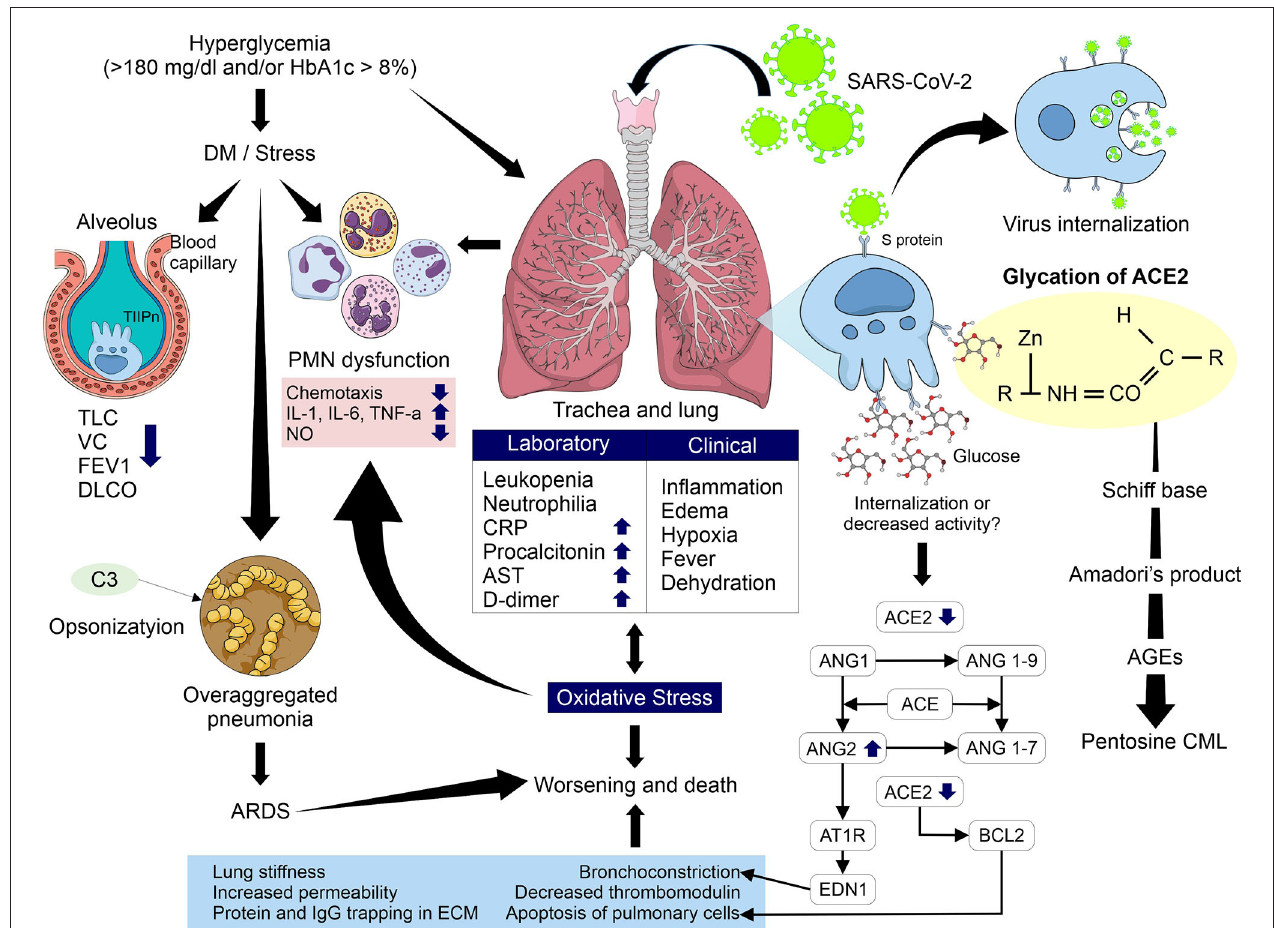
FIGURE 4 | Pathophysiological mechanism involved in glycation of ACE2 in uncontrolled hyperglycemic patients with and without DM and its relationship with complications and mortality due to COVID-19. Glycation may modify the activity of ACE2 causing a several reactions such as increased levels of Ang II, greater interaction with its receptor AT1R, increasing levels of endothelin-1, decreased activity of Bcl-2, and greater interaction of glycation products with type II pneumocytes. These processes increase bronchoconstriction, apoptosis of pulmonary cells, lung stiffness, permeability, and protein and IgG trapping in ECM and decreased thrombomodulin. In addition, an increase in OS, PMN dysfunction and the alterations induced by hyperglycemia and the higher risk of over-aggregated pneumonia in COVID-19 patients could increase the risk of ARDS and therefore of worsening evolution and death. TLC, total lung capacity; VC, vital capacity; FEV1, forced expired volume in 1 second; DLCO, Pulmonary diffusion capacity; PMN, polymorphonuclear; IL, interleukin; TNF- α , tumor necrosis factor alpha; NO, nitric oxide; CRP, C-reactive protein; AST, aspartate aminotransferase; T2Pn, type 2 pneumocytes; ACE, angiotensin converting enzyme; ACE2, angiotensin converting enzyme 2; Ang, angiotensin; AT1R, angiotensin type 1 receptor; AGEs, advanced glycation end products; CML, N ε - carboxymethyl-lysine; Bcl-2, B cell lymphoma; ARDS, acute respiratory distress